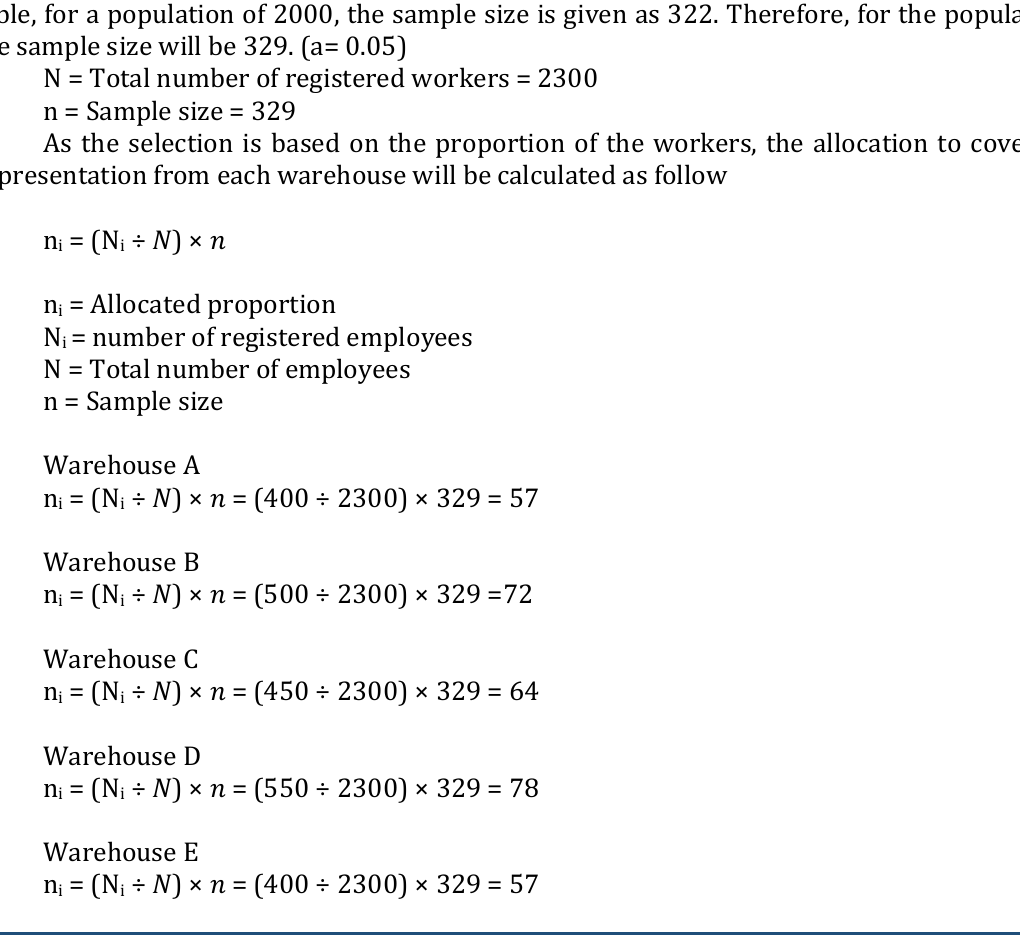
Table 2: Proportion allocation of workers defined by warehouses Warehouse